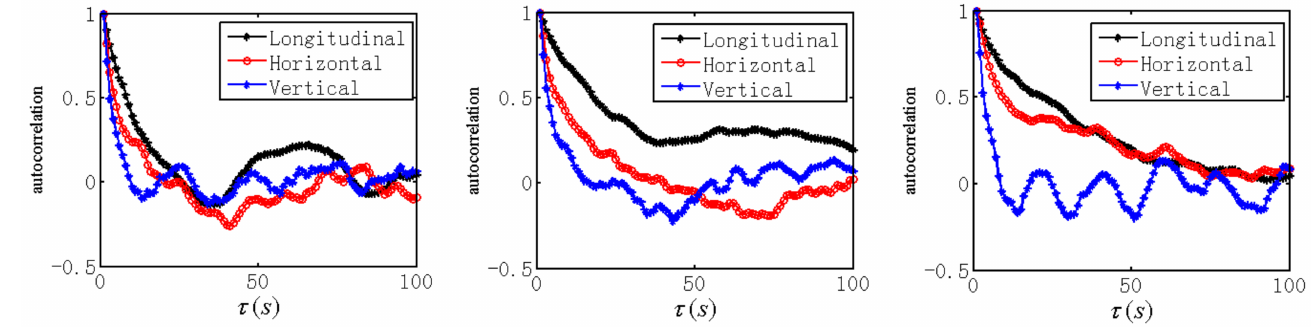
Figure 23. Autocorrelation coefficients of wind speed fluctuation components (10 m, 80 m, and 100 m).